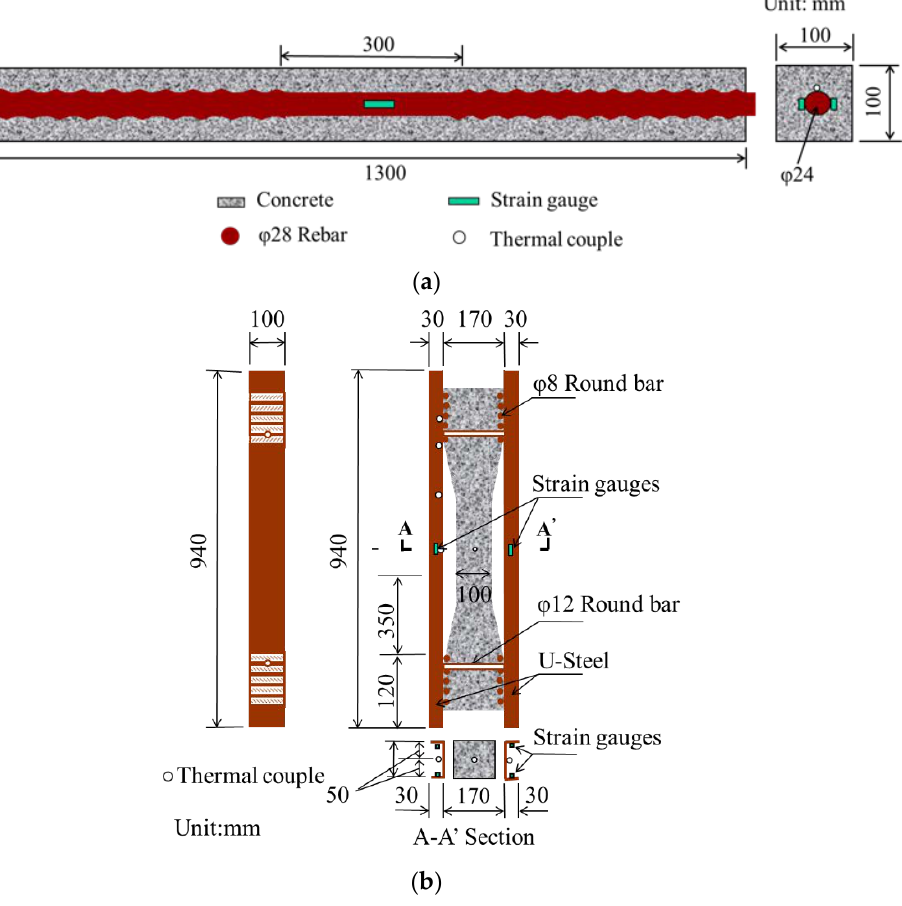
Figure 3. Illustrations of rebar restraint and U-steel restraint: (a) Rebar restraint; (b) U-steel restraint.